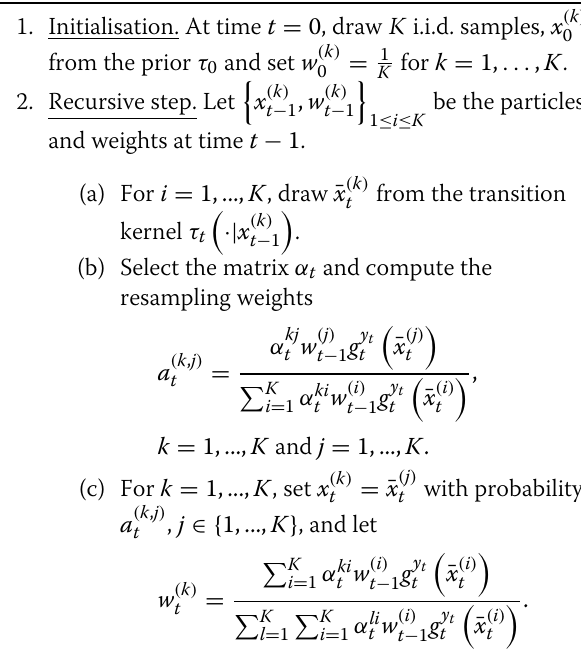
Algorithm 4: α -SMC